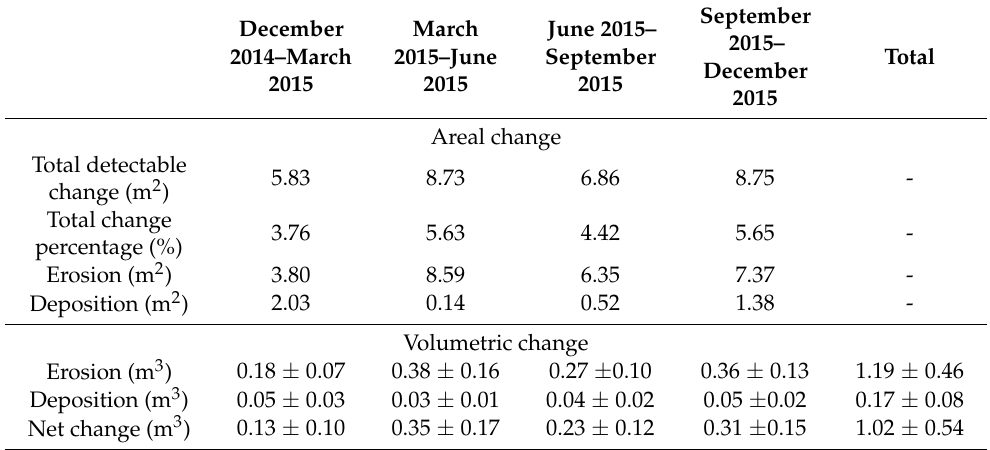
Table 2. Results of DoD analysis between DEMs surveyed between December 2014 to December 2015.